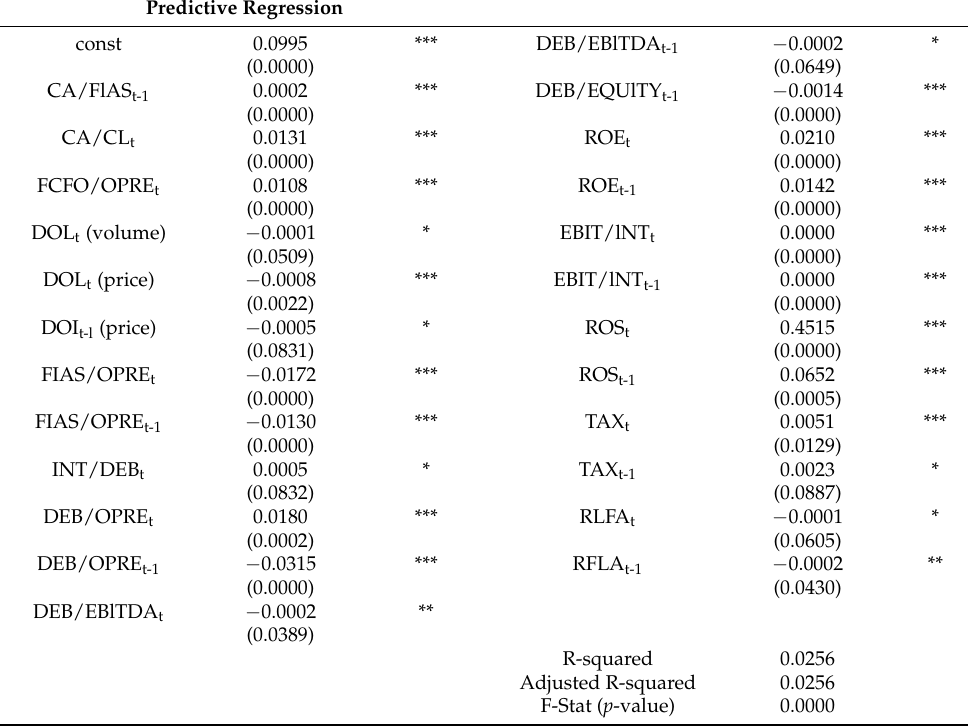
Table 3. Predictive regression statistics.